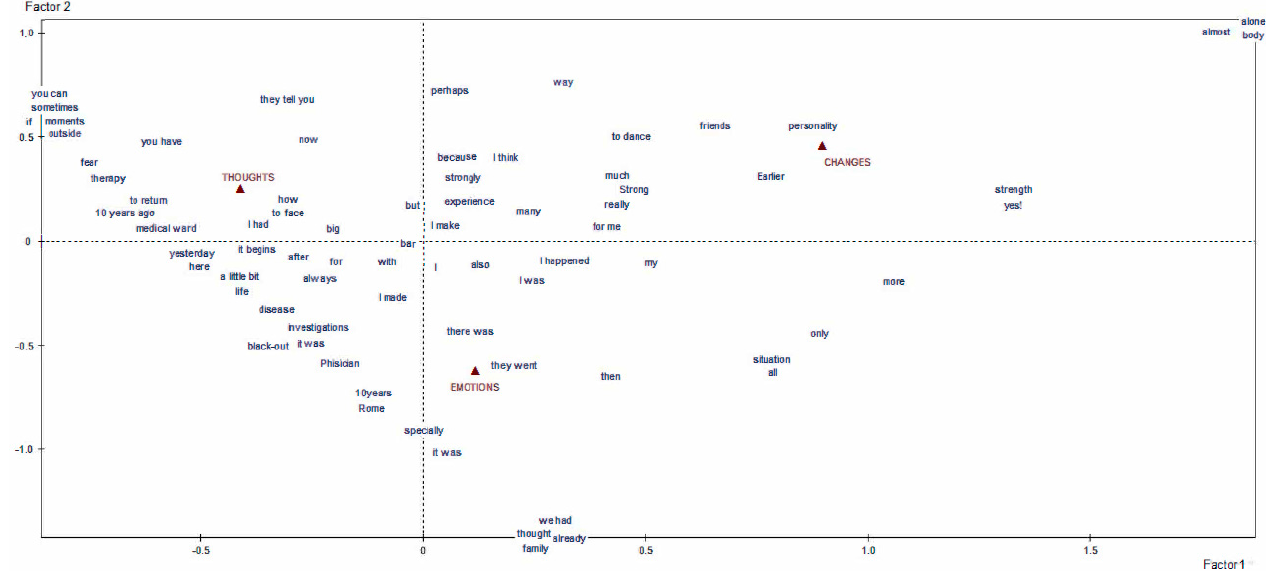
Figure 2. Graphic representation of the second outcome, about “patients’ thoughts, fears, and changes in their self-perception” .